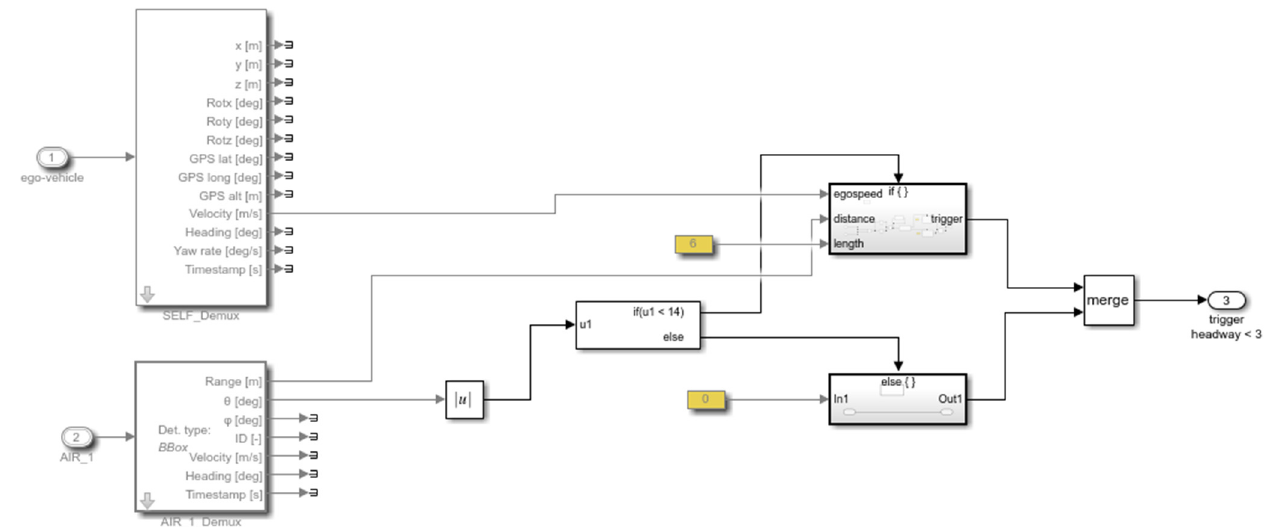
Figure 10. Time headway trigger for preceding vehicle in Simulink.